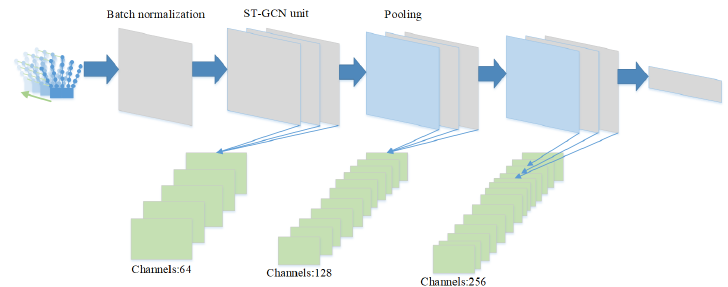
Figure 3. Figure convolutional network model structure.